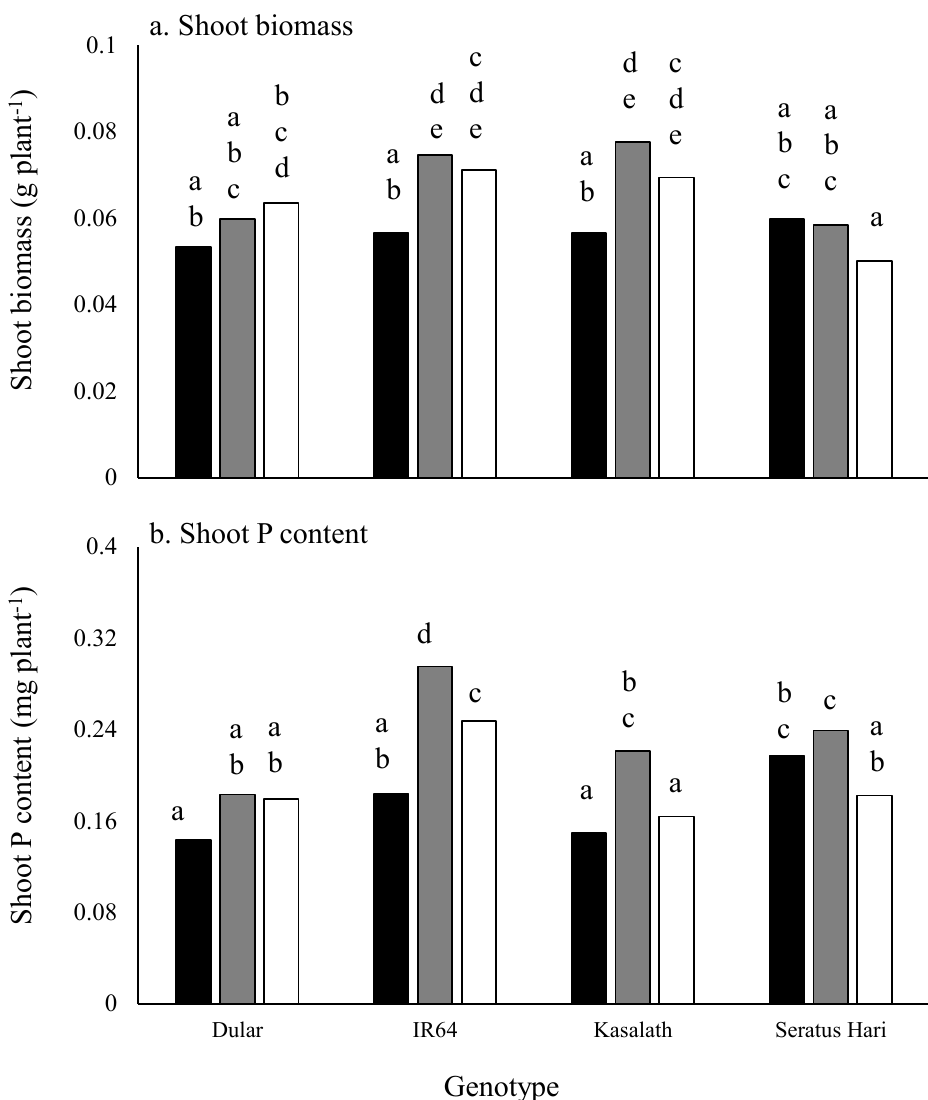
Figure 1. Effect of genotype and phosphorus fertiliser treatment on ( a ) shoot biomass and ( b ) shoot P content of 25-day-old rice seedlings grown in a high-phosphorus-fixing Ferralsol. Black bars represent nil P fertiliser, grey bars represent broadcast phosphorus fertiliser and white bars represent banded phosphorus fertiliser. Bars that do not share a common letter are significantly different at p ≤ 0.05.